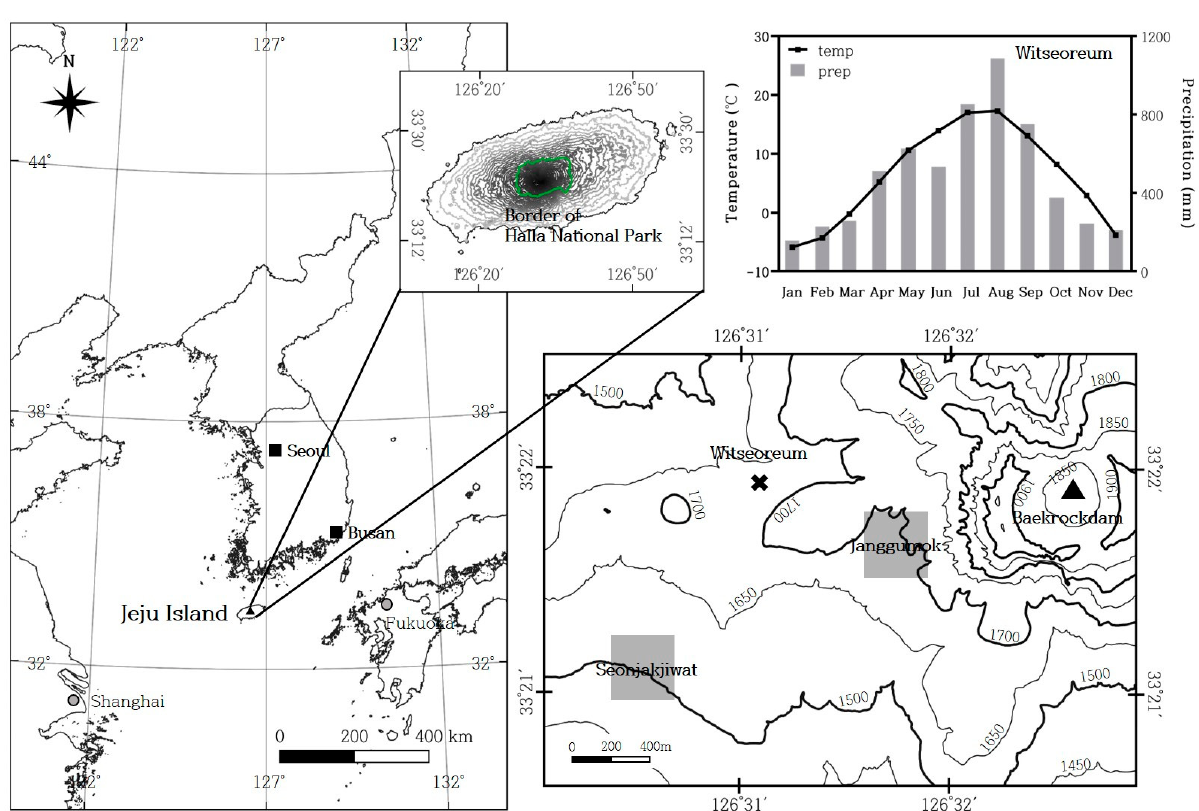
Figure 2. Locations of Mt. Halla and the sampling sites therein (grey box) with monthly mean temperature (temp) and precipitation (prep) (right top) from the Witseoreum meteorological station (cross mark in right bottom).